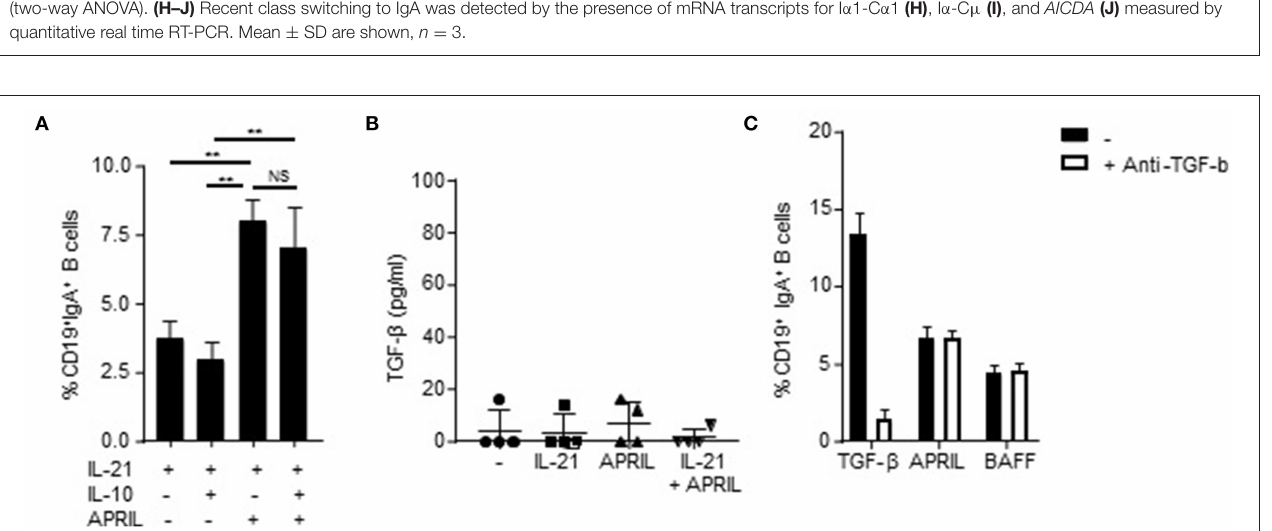
FIGURE 3 | APRIL-induced CSR to IgA is independent of autocrine TGF- β or IL-10 signaling. (A) Percentage of class-switched IgA + B cells at day 6 of culture in the presence of CD40L-expressing fibroblasts, IL-21, and indicated stimuli. Mean ± SD are shown, n = 3. ** P < 0.01 and NS: not significant (one- or two-way ANOVA with Bonferroni multiple comparison test). (B) Human naïve B cells were cultured for 3 days in the presence of CD40L-expressing fibroblasts and indicated stimuli, whereafter the culture supernatant was harvested and TGF- β was detected using ELISA. N = 4. (C) Naïve human B cells were cultured for 6 days in the presence of CD40L-expressing fibroblast, IL-21 and indicated stimuli. Neutralizing antibodies to TGF- β (100ng/ml) were added at day 0 and 3 of the culture. After 6 days, the B cells were harvested and the percentage of class-switched IgA + B cells was detected using flow cytometry. Mean ± SD are shown, n =